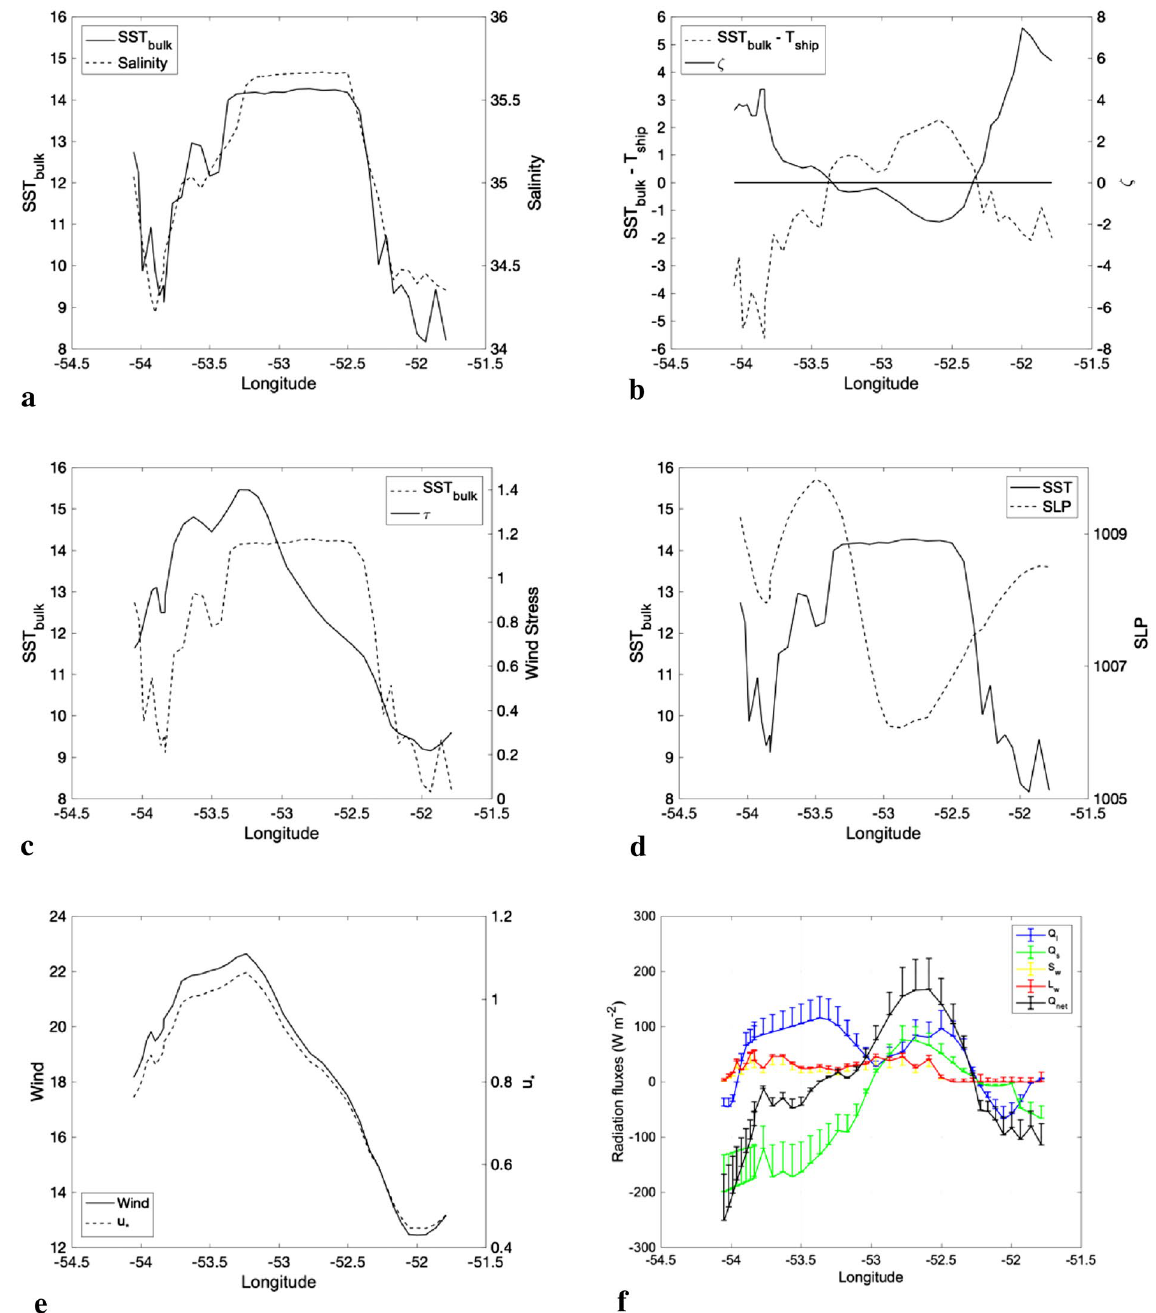
Figure 4. Synoptic, in situ measurements taken along Brazilian Navy Polar Vessel (Po/V) Almirante Maximiano (H41) route while crossing the eddy. (a) SST bulk (°C) and salinity. (b) Stability parameters, ζ and SST—T air (°C). (c) SST bulk (°C) and wind stress (N m -2 ). (d) SST bulk (°C) and sea level pressure (hPa). (e) Wind speed magnitude and friction velocity (u * ), both in m s -1 . (f) Components of net heat flux (Q net ), short and long wave radiation (S w and L w ), latent and sensible heat fluxes (Q l and Q s , both measured by eddy covariance) in W m -2 . The bars in (f) are the standard error oriented up for visual clarity representing 95% confidence interval. However, they must be interpreted both up and down. All information is derived from the ship-borne meteorological data. MATLAB, Version 9.1.0.441655 (R2016b). https:// www. mathw orks.